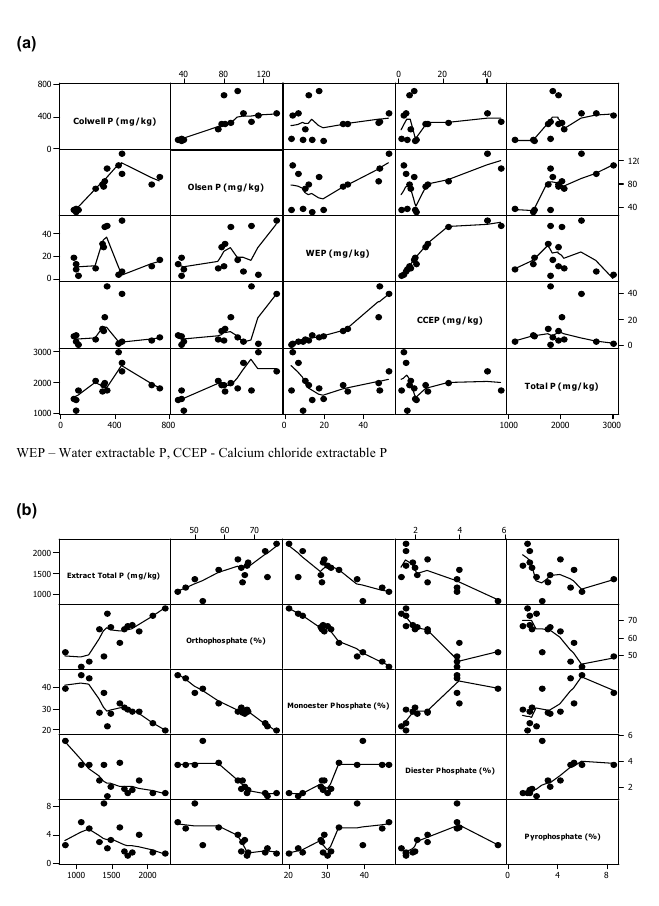
Figure 3. Scatter plots of the trend between some of the inorganic and organic P levels in the soil samples. ( a ) Colwell P, Olsen P, water extractable P (WEP), calcium chloride extractable P (CCEP) and Total P as mg/kg; ( b ) Extractable total P, orthophosphate, monoester P, diester P and pyrophosphate as percentage (%).